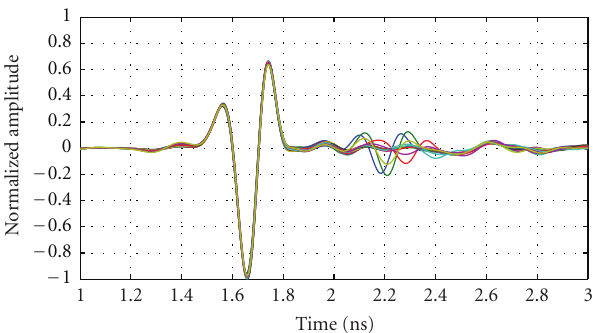
Figure 11: Cross-section through the voxelized simulation model of phantom showing components of the prototype included to more accurately model